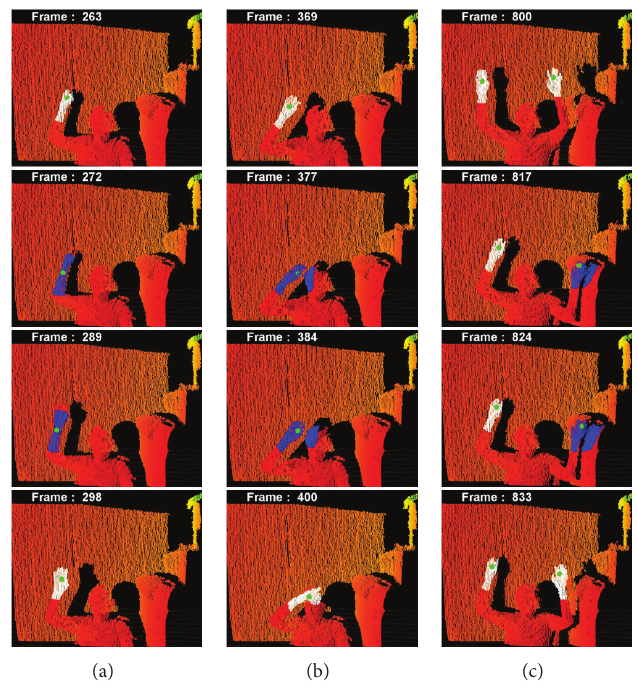
Figure 17: Example of tracking confidence.